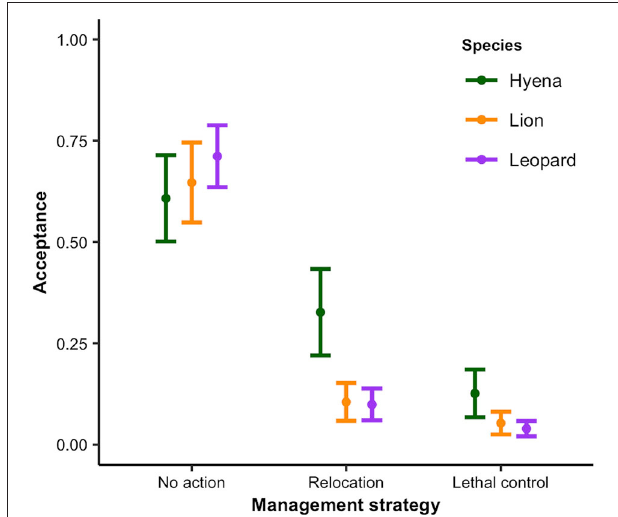
FIGURE 3 | Cumulative predicted probability of the acceptance (score > 4) of no action, relocation, and lethal control as management strategies toward hyenas, lions, and leopards by Maasai pastoralists in Ngorongoro Conservation Area, Tanzania. Points represent mean predicted probabilities from an ordinal logistic regression model and bars represent the 95% confidence intervals when continuous predictors are held at their population